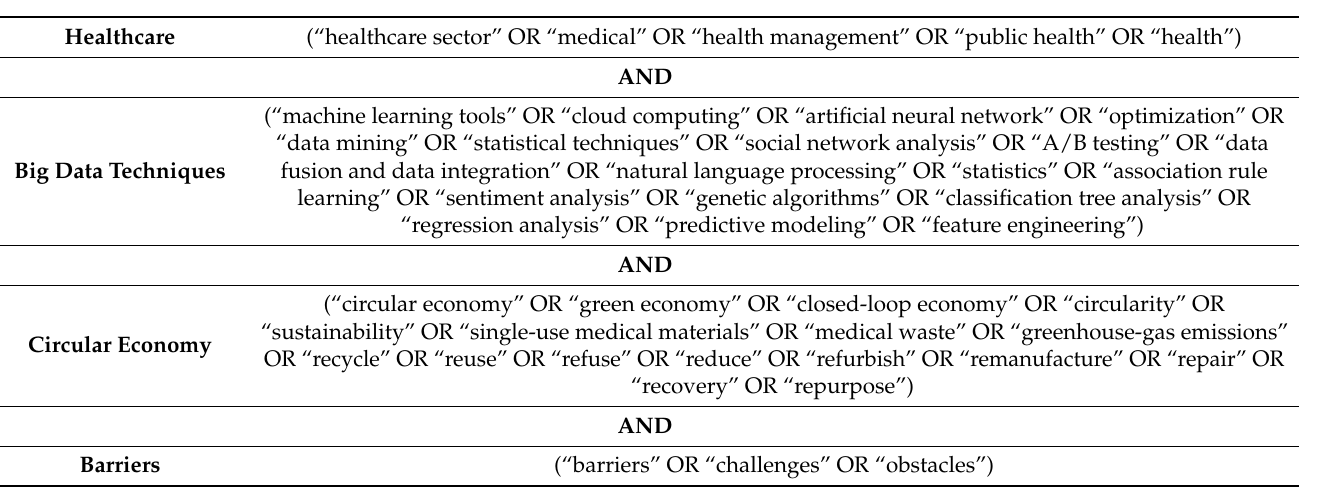
Table A1. The Search Strings for Examination of